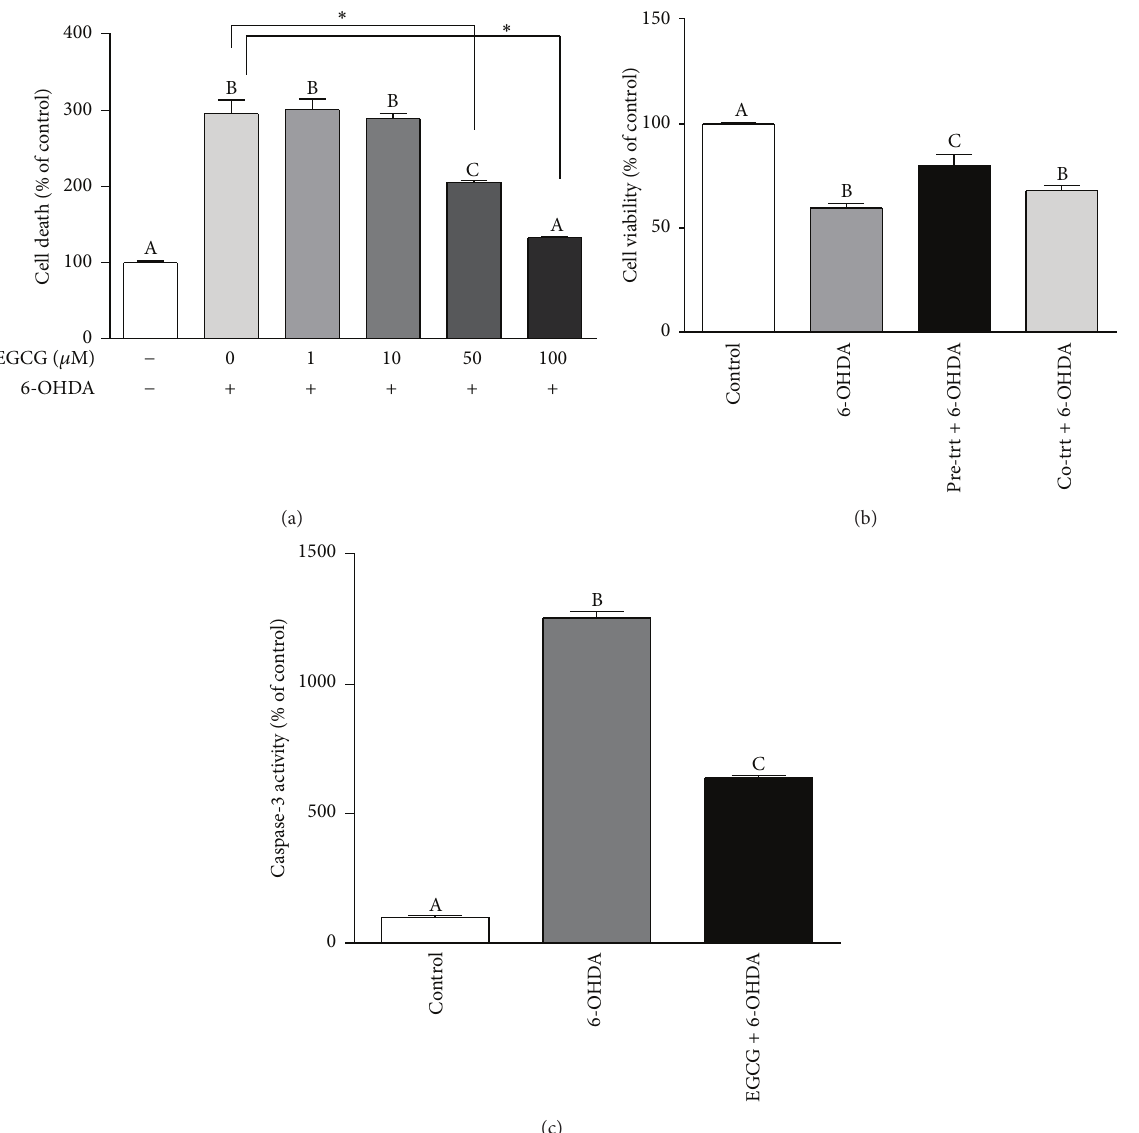
Figure 1: Effect of 6-OHDA and EGCG on N27 cell death, cell viability, and cell apoptosis. Data are represented as % of control (no treatment). Cell death (a) was determined by SYTOX green assay, and values are mean ± SEM, 𝑛 = 8 . Cells were pretreated with EGCG for 2h followed by 100 𝜇 M 6-OHDA treatment for 6h. Bars without common letters differ. Cell viability (b) was evaluated by MTT assay. 6-OHDA, 100 𝜇 moles/L for 6 h; EGCG, 100 𝜇 moles/L. Pre-trt EGCG: pretreatment for 2h; Co-trt EGCG: cotreatment with 6-OHDA. Values are mean ± SEM, 𝑛 = 6 . Cell apoptosis (c) was measured as caspase-3 activity. 6-OHDA (100 𝜇 M) for 6 h following EGCG (100 𝜇 M) pretreatment for 2 h. Values are mean ± SEM, 𝑛 = 3 . Labeled bars without a common letter differ. ∗ 𝑝 < 0.001